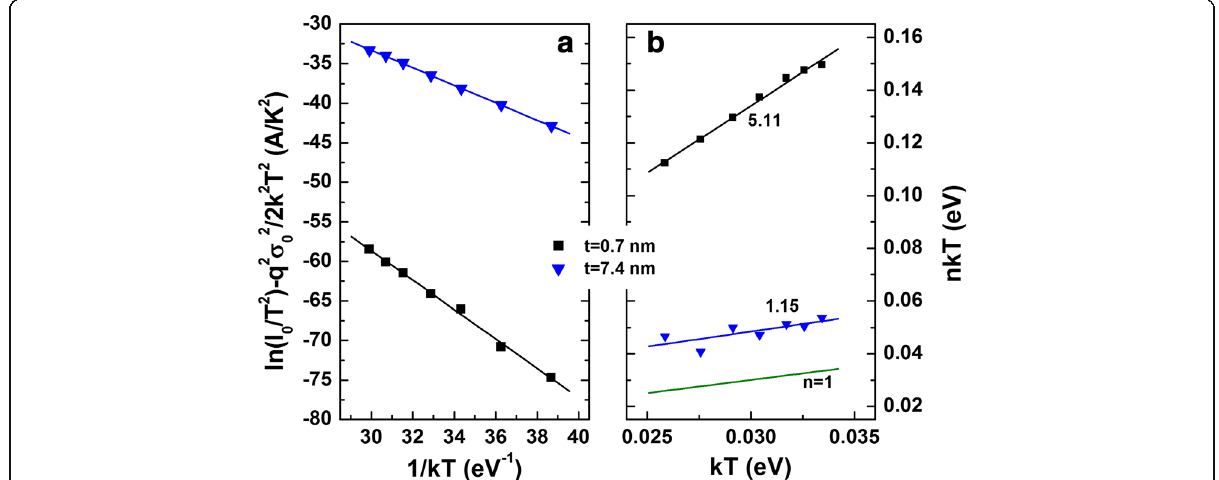
Fig. 8 a Modified Richardson plots and b nkT vs. kT plots with the linear fits to the experimental data. In b , the line with a slope of 1 ( n = 1) was also included as a